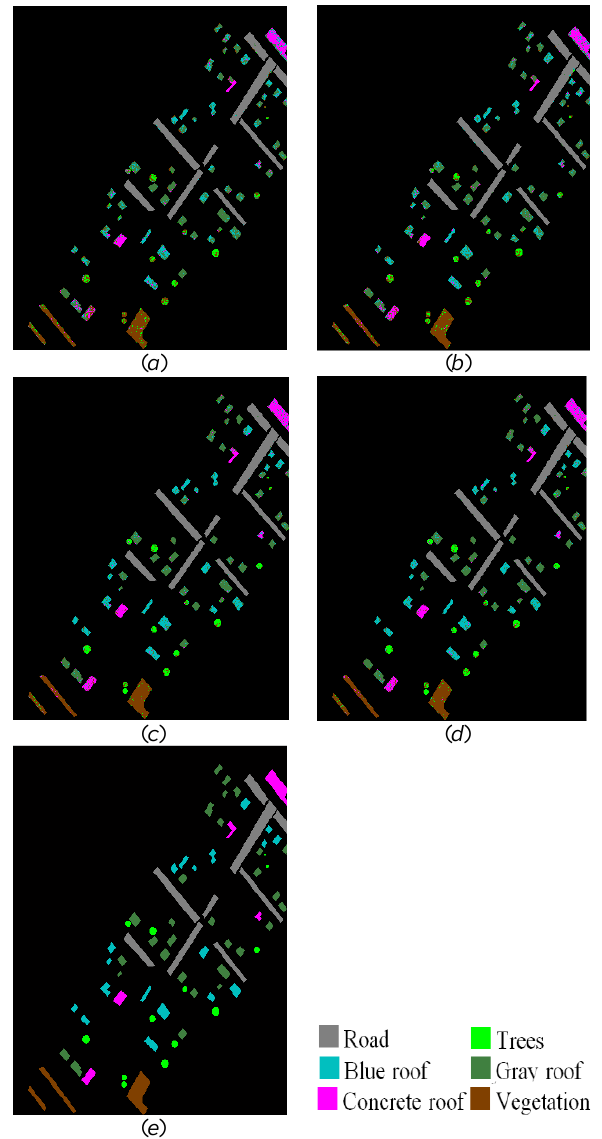
Figure 2. ( a ) MLP Classification map, ( b ) original-MHS classification map, ( c ) enhanced-MHS Classification map, ( d ) proposed Classification map, ( e ) Reference data.